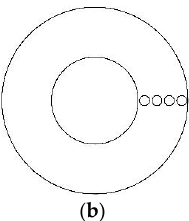
Figure 1. Disc pattern and reading head distribution of absolute encoder using a length-4 Gray code: ( a ) Schematic of the coding disc, where the white area indicates “0”, and the black area indicates ”1”; ( b ) Schematic of the reading disc, where the four small circles denote the four reading heads corresponding to the four coding tracks.